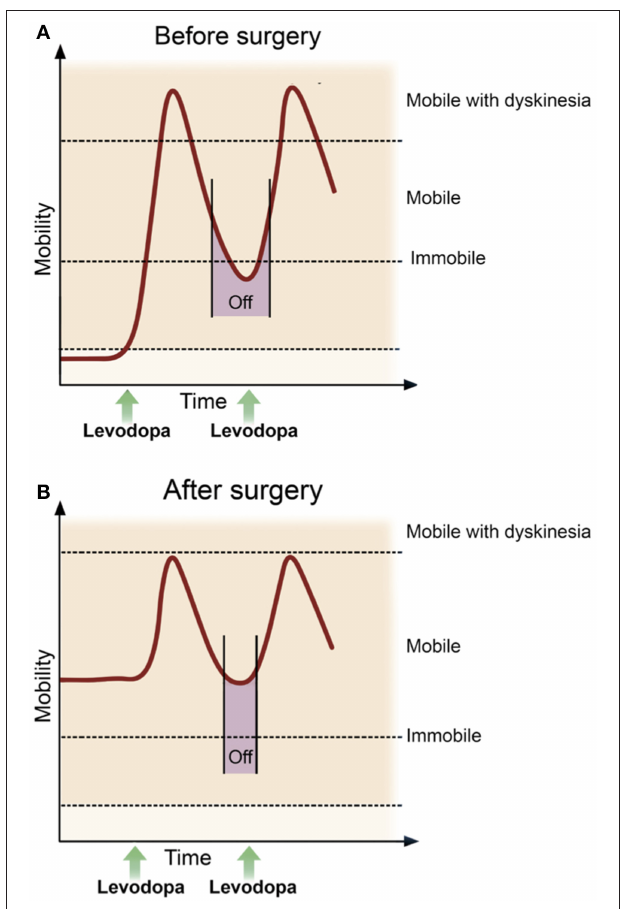
FIGURE 1 | Mobility and motor function pre- and post-deep brain stimulation. In advanced Parkinson’s disease (A) the duration of response after a single dose of levodopa becomes progressively shorter, thus it becomes increasingly difficult to maintain a satisfactory ON state, with OFF periods (purple bar) and dyskinesia often predominating. While most patients continue to take medication after surgery, the goal following DBS (B) is a reduction in the duration and severity of OFF time, more consistent and longer ON time, as well as an improvement in dyskinesia. Advances in sensing and stimulating technologies promise to enhance DBS delivery, further reducing variability in motor function and improving clinical efficacy. Adapted from Deuschl and Agid